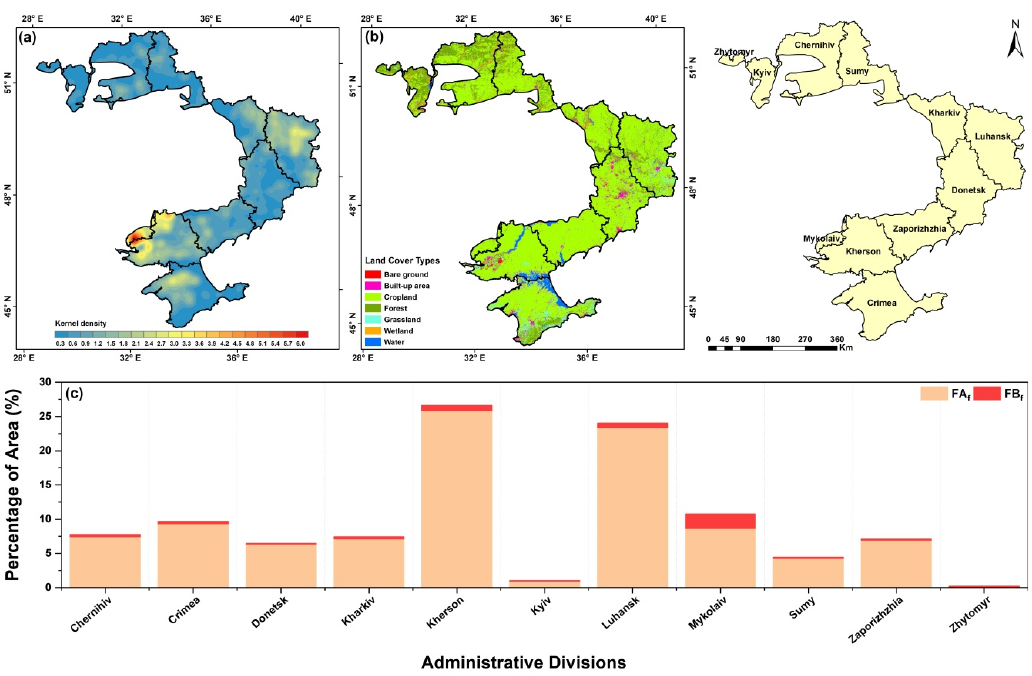
Figure 6. ( a ) illustrates the kernel density map of fallowed cropland in war zones; ( b ) illustrates the level-1 land cover classification map of the war zones; ( c ) illustrates the statistical graph of area percentage of fallowed cropland. FA f represents the area of fallowed cropland in each administrative region as a percentage of the total fallowed cropland area in war zones. FB f represents the area of fallowed cropland as a percentage of the cropland area in each administrative region.